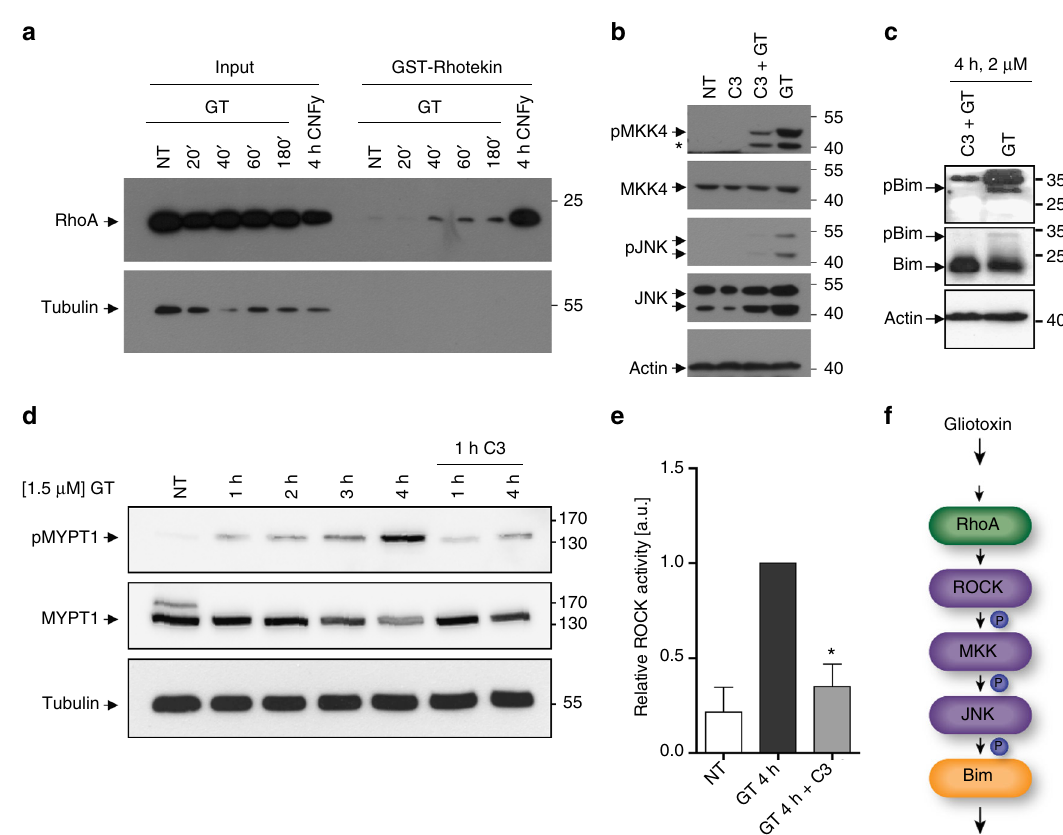
Fig. 3 GT triggers RhoA and subsequent ROCK activation. a Anti-RhoA western blot analysis showing the pulldown of active RhoA-GTP with GST-Rhotekin beads from total extracts of BEAS-2B cells either treated with 1 µ M GT for 20, 40, 60 and 180 min or with the bacterial toxin CNFy for 4 h (positive control). The left side of the western blots shows equal RhoA input for each pulldown. b Western blot analysis of total extracts of BEAS-2B cells either untreated (NT) or treated with 1 µ M GT in the absence or presence of the RhoA-inhibiting C3 toxin for 6 h showing a diminishment of GT-induced MKK4 and JNK phosphorylation by the C3 toxin. c Western blot analysis of total extracts of BEAS-2B cells treated with 2 µ M GT in the absence or presence of the C3 toxin for 4 h showing that the toxin diminishes GT-induced Bim phosphorylation at T112/S114 (pBim). d Anti-MYPT1 and pMYPT1 western blot analysis of total extracts of BEAS-2B cells either untreated (NT) or treated with 1.5 µ M GT in the absence or presence of the C3 toxin for 1 – 4 h showing that the toxin ablated the GT-induced phosphorylation of the ROCK substrate MYPT1. e Lumi Imager FusionSL Vilber Lourmat quanti fi cation of the chemiluminescent immunoblot bands shown in d . f Schematic representation of how GT activates RhoA and subsequently triggers a